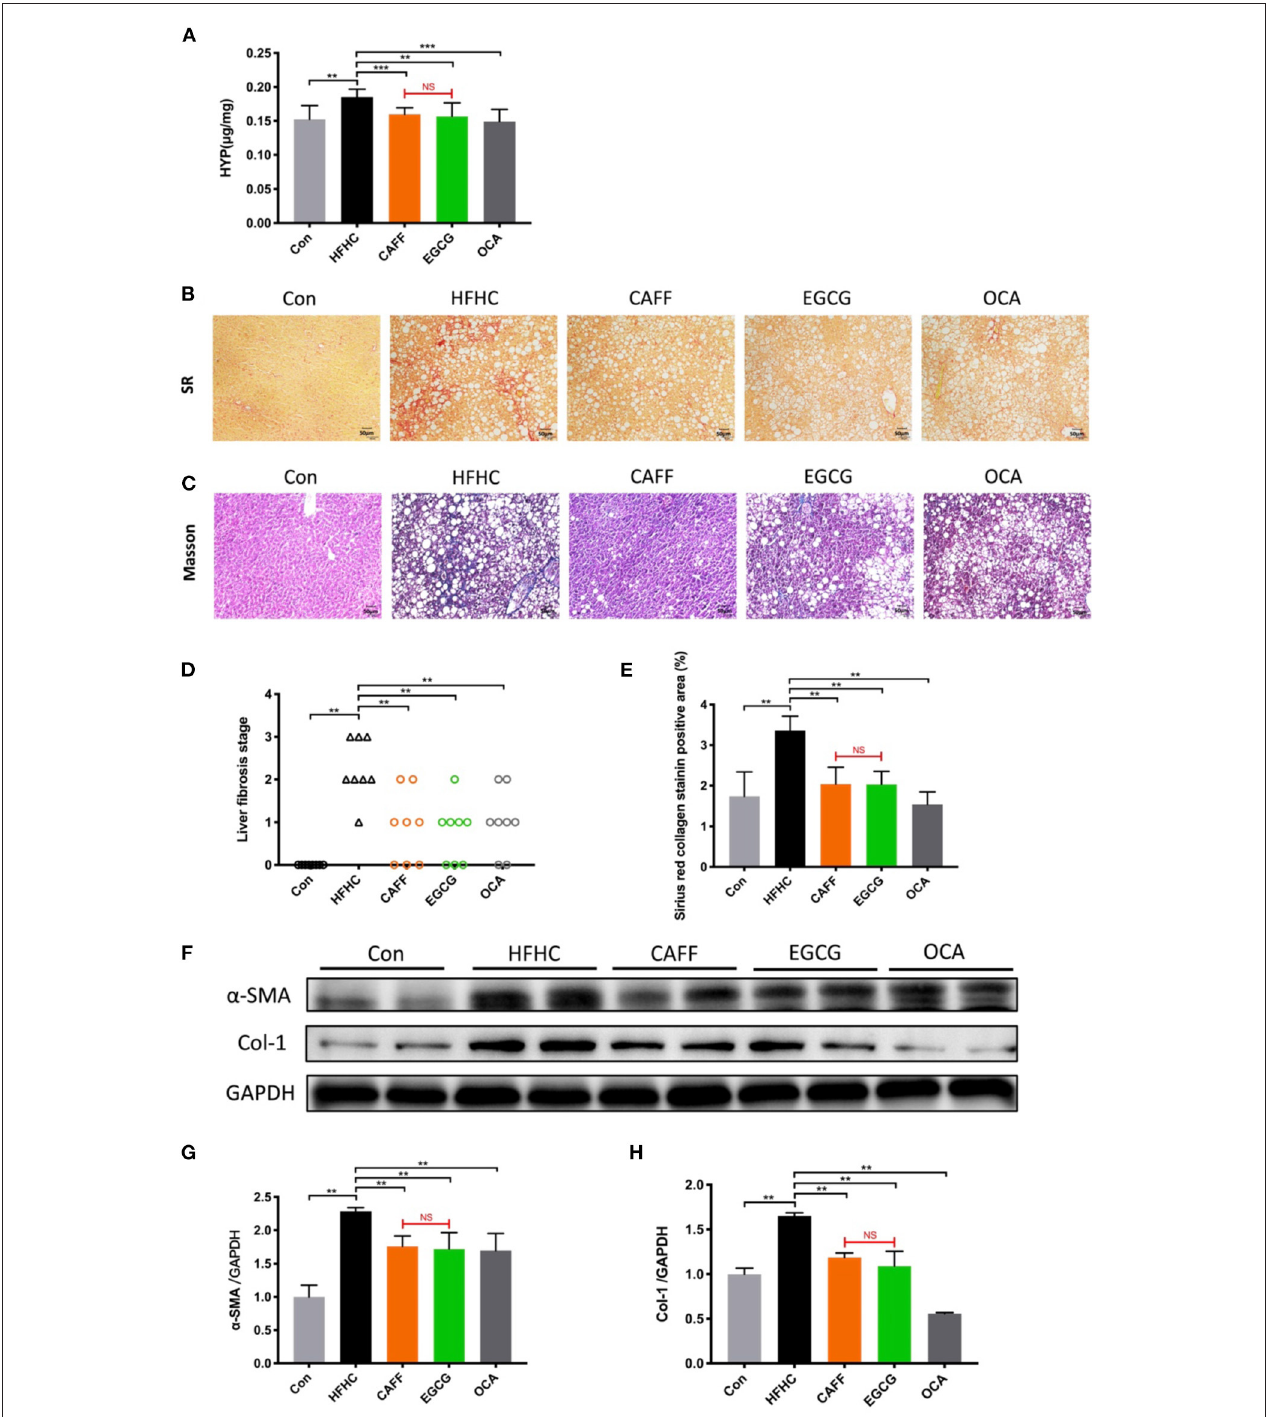
FIGURE 5 | Caffeine and EGCG Strongly Attenuate liver fibrosis in NASH mice (A) Total liver collagen (hydroxyproline, HYP). (B) Sirius red staining (200 × ), red color indicates fibrosis. (C) Masson trichrome staining (200 × ), blue color indicates fibrosis. (D) Liver fibrosis stage ( n = 8). (E) Liver fibrosis areas with positive collagen levels by semiquantitative analysis of Sirius red staining ( n = 8). (F–H) Col-1 and α -SMA protein expression levels in liver tissue vs. HFHC, ** P < 0.01, *** P < 0.001; vs. EGCG, NS, not significant.